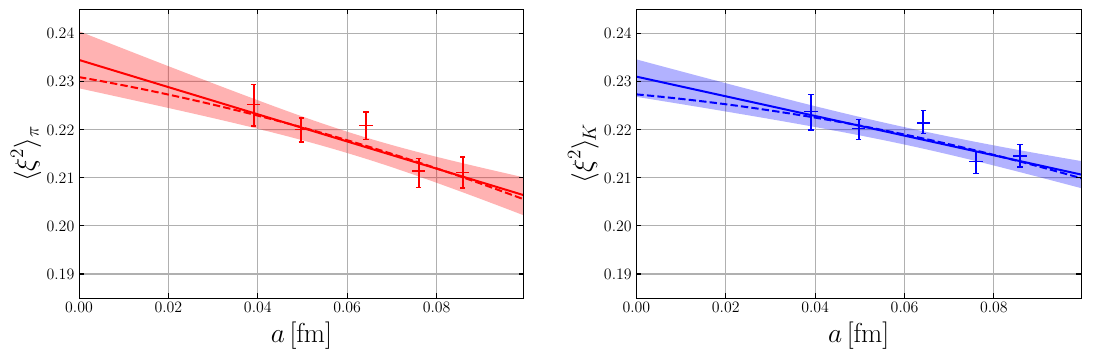
Figure 7 . Dependence of the moments on the lattice spacing a , plotted at physical quark ξ 2 (cid:31) (cid:30) M masses. The points shown have been obtained by translating all data along the fitted function (keeping the lattice spacing fixed) and then averaging measurements with the same a . The plots for the individual trajectories can be found in figure 12 in appendix A. The solid lines and shaded statistical error bands represent our main result. The dashed curves correspond to the mean value of an alternative fit (including a term proportional to a 2 ) used to estimate the parametrization dependence as described in the main